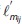
Effect of BT8 on the MAIR by département.
Département-level effects are shown for heifers (Fig. 3A, on the left) and parous cows (Fig. 3B, on the right). Départements in dark gray were excluded because they reported BT8 and BT1 cases; départements in light gray are those excluded from the study because the marginal probability density functions of ℓmij' and kmij' were multimodal, with the probability value of the second best mode higher than half of the value of the major mode. The effect of the mean number of BT8 cases during the département-specific weighted average time interval on the weekly MAIR was positive in départements in dark pink, non-significant in départements in light pink, and negative in départements in pale pink.